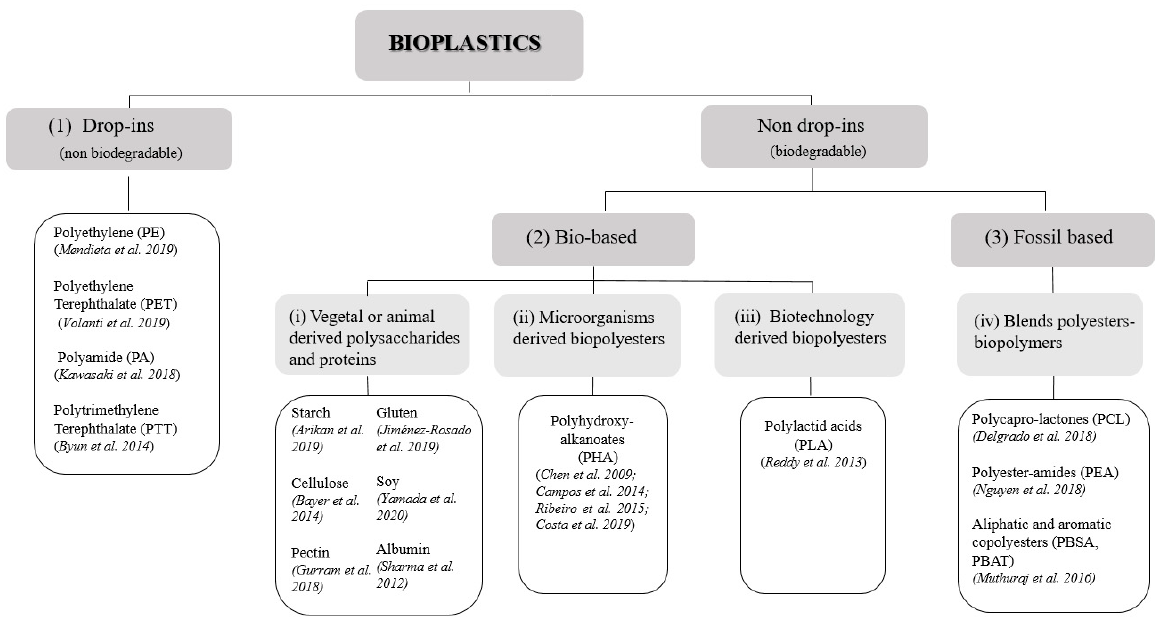
Figure 1. Scheme of bioplastics classification: (1) Drop-in bioplastics (i.e., bio-based or partly bio-based but non-biodegradable plastics), (2) bio-based non drop-in bioplastics, and (3) fossil based non drop-in bioplastics. According to their origin, non-drop-ins (i.e., biodegradable plastics) are divided into (i) vegetal or animal derived polysaccharides and proteins, (ii) polymers from microorganism, (iii) polymers from biotechnology, and (iv) blends of biopolymers and commercial polyesters [25].